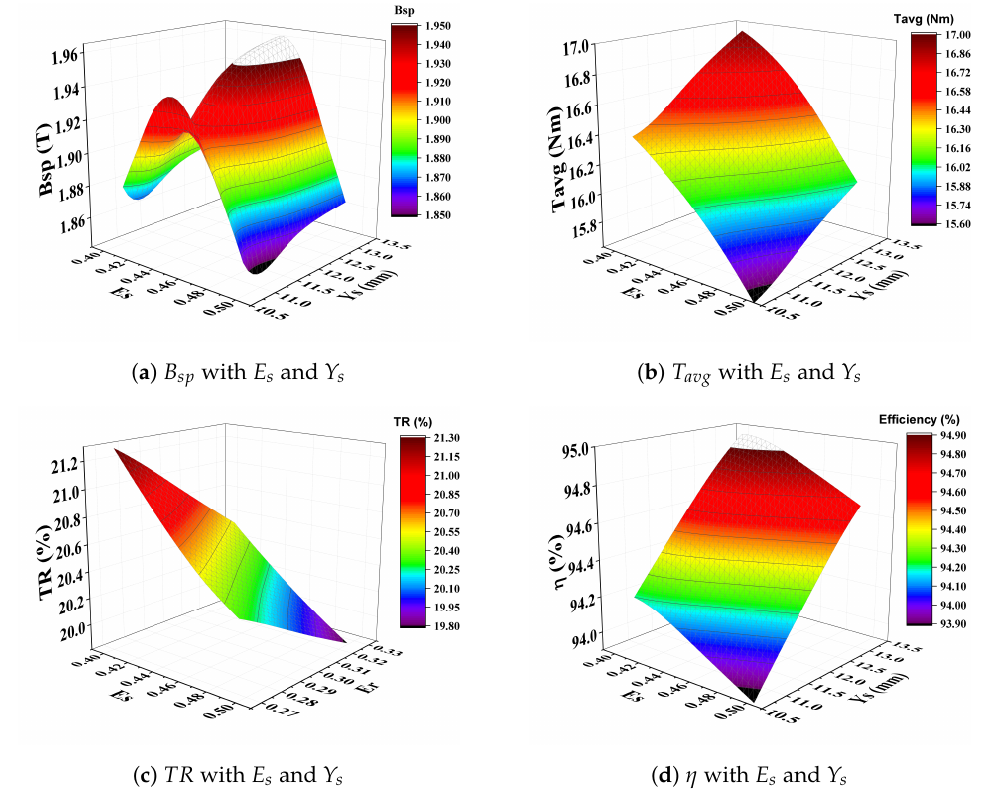
Figure 11. 3D Response surface plots of the SRM. The plots display three-dimensional relationship between the parameters and are useful for establishing desirable response